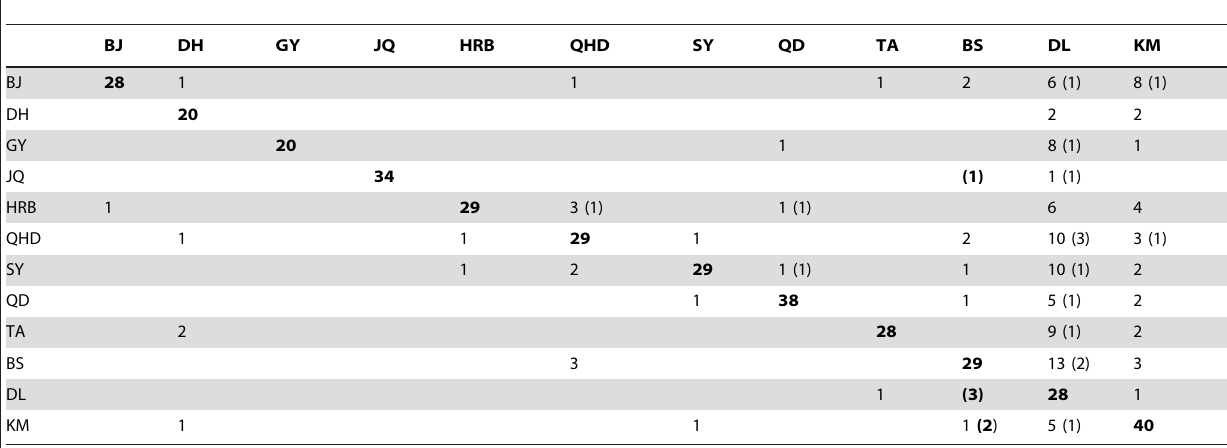
Table 5. Results of assignment test and detection of first generation migrants (F0), with source populations list by column and recipient populations by